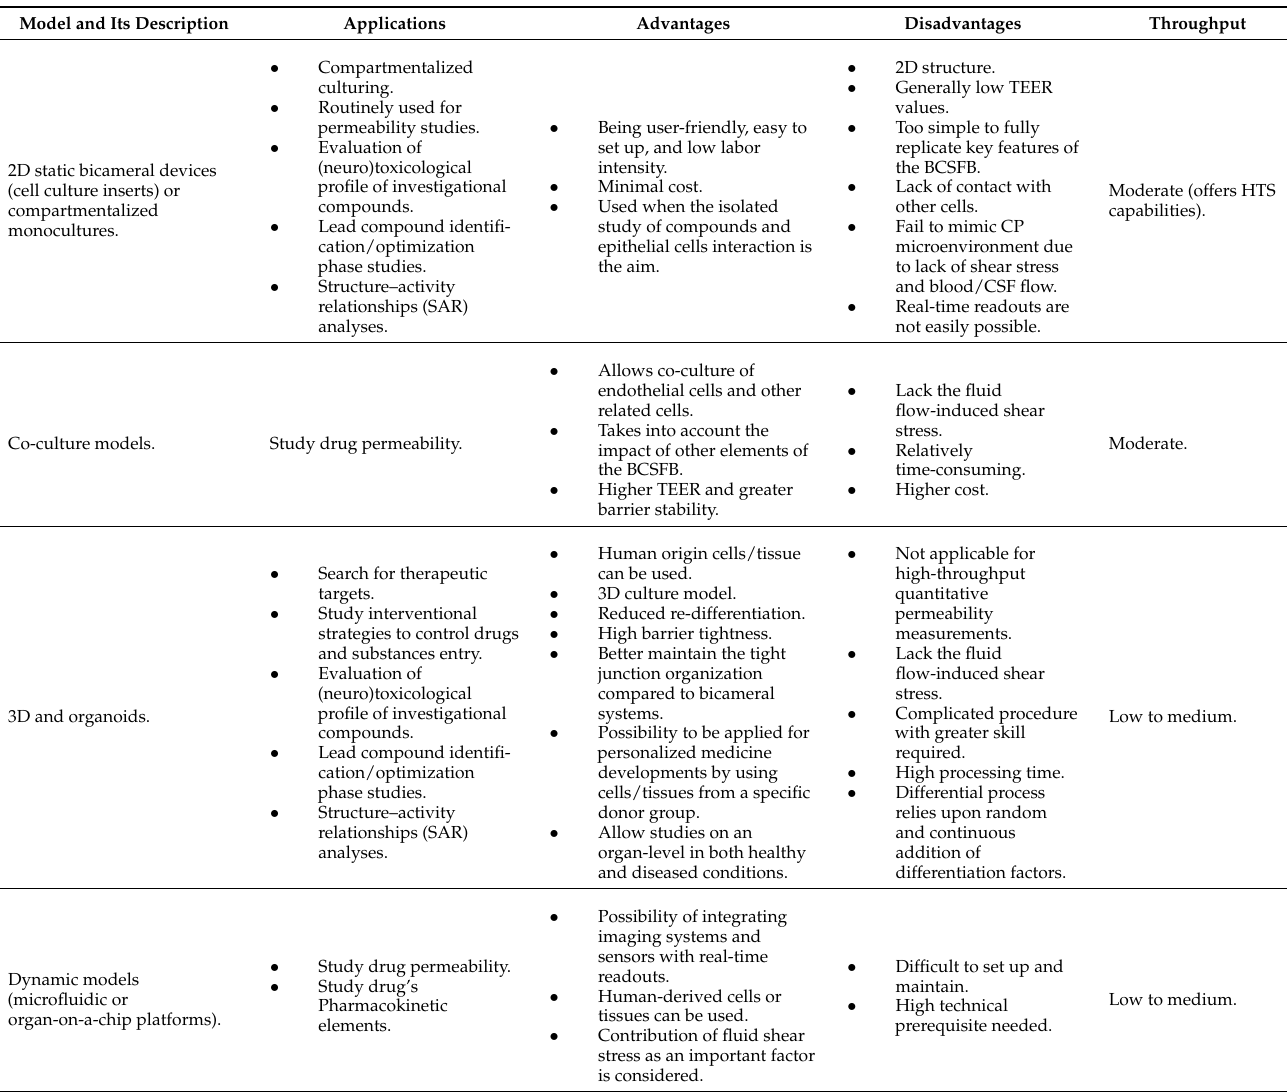
Table 2. Summary of in vitro BCSFB